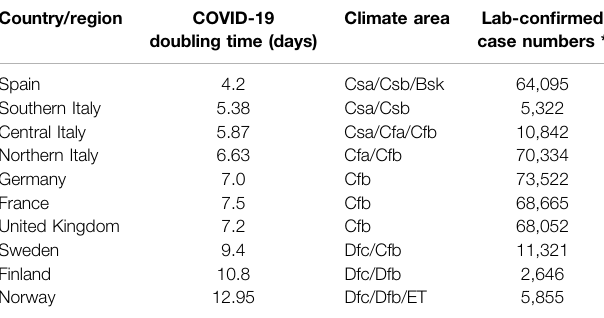
TABLE 1 | COVID-19 doubling time versus climate